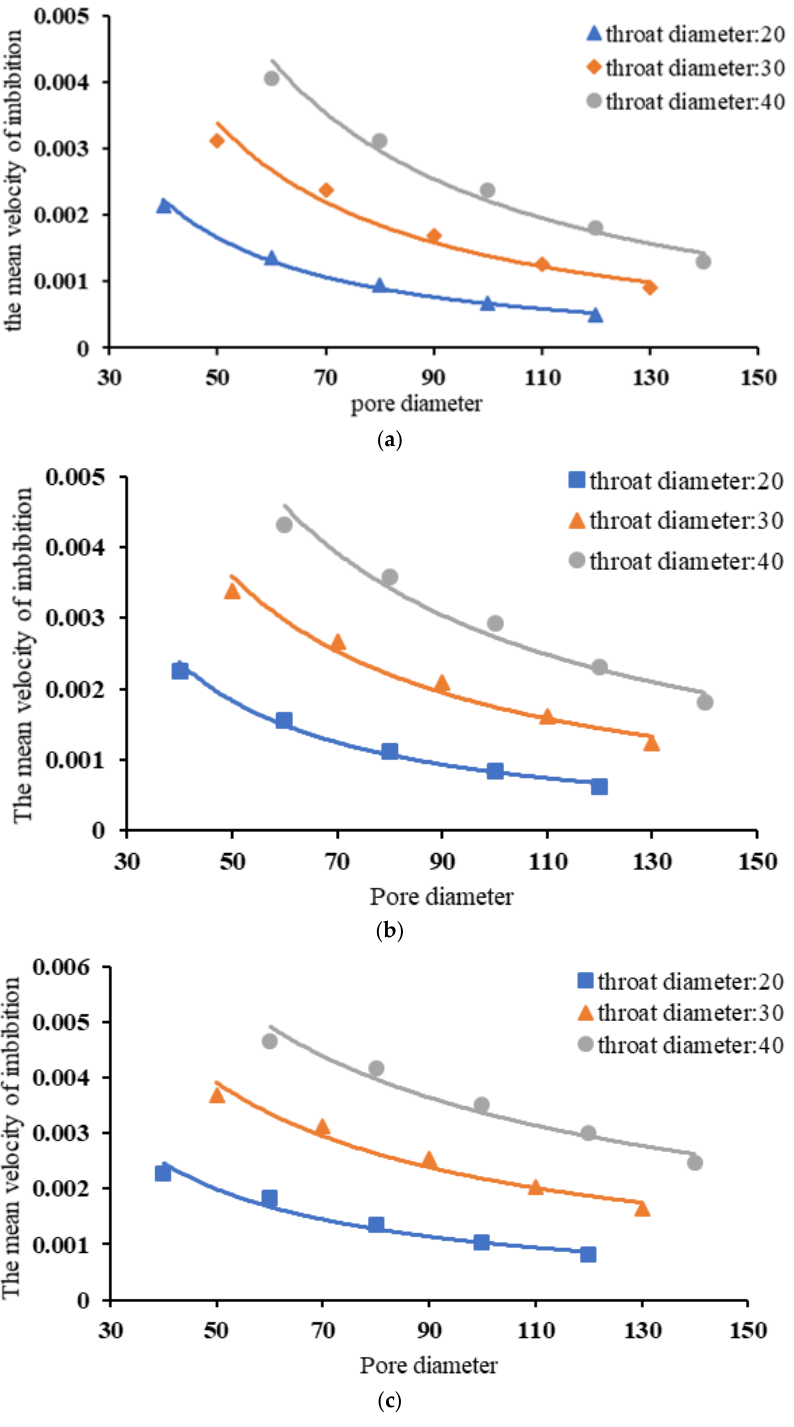
Figure 19. The relationship between the average spontaneous imbibition velocity and pore diameter when throat diameter d t is fixed. ( a ) The period is 40 π and d t = 20, 30, and 40. ( b ) The period is 50 π and d t = 20, 30, and 40. ( c ) The period is 70 π and d t = 20, 30, and